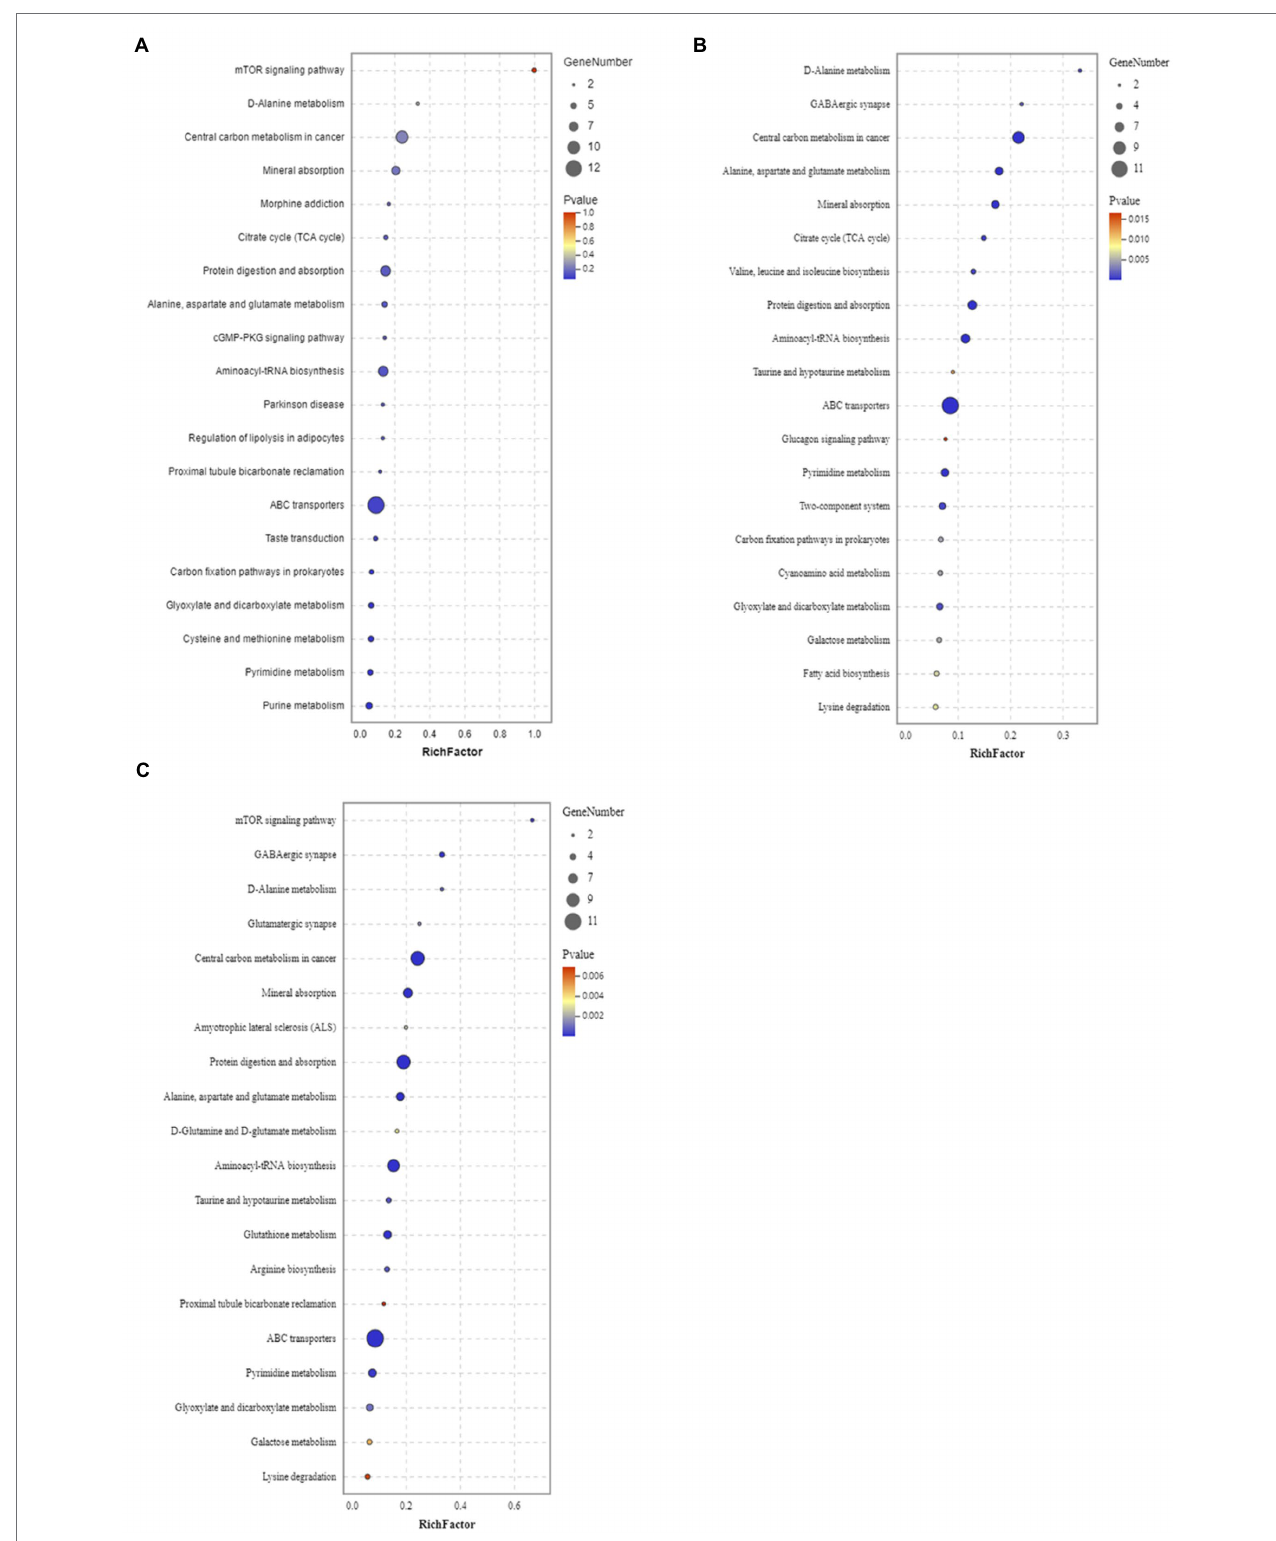
FIGURE 5 | Enrichment analysis results of KEGG pathway in positive ion mode. Male and female Sargassum thunbergii in (A) control group; (B) low UV-B radiation conditions; and (C) high UV-B radiation conditions. The abscissa represents rich factors (calculated by the significantly regulated metabolites numbers of given metabolic pathway/all metabolite numbers of corresponding metabolic pathway) and the ordinate represents different metabolic